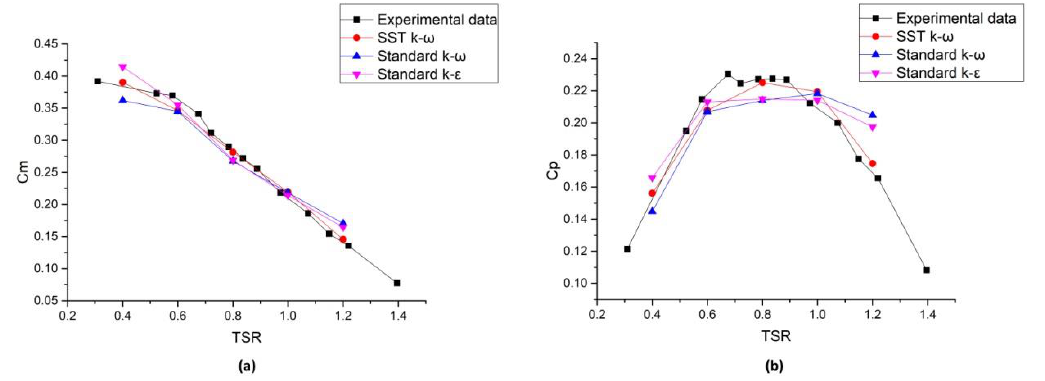
Figure 8. Numerical method validation. ( a ) Validation of the turbine torque; ( b ) validation of the turbine power.